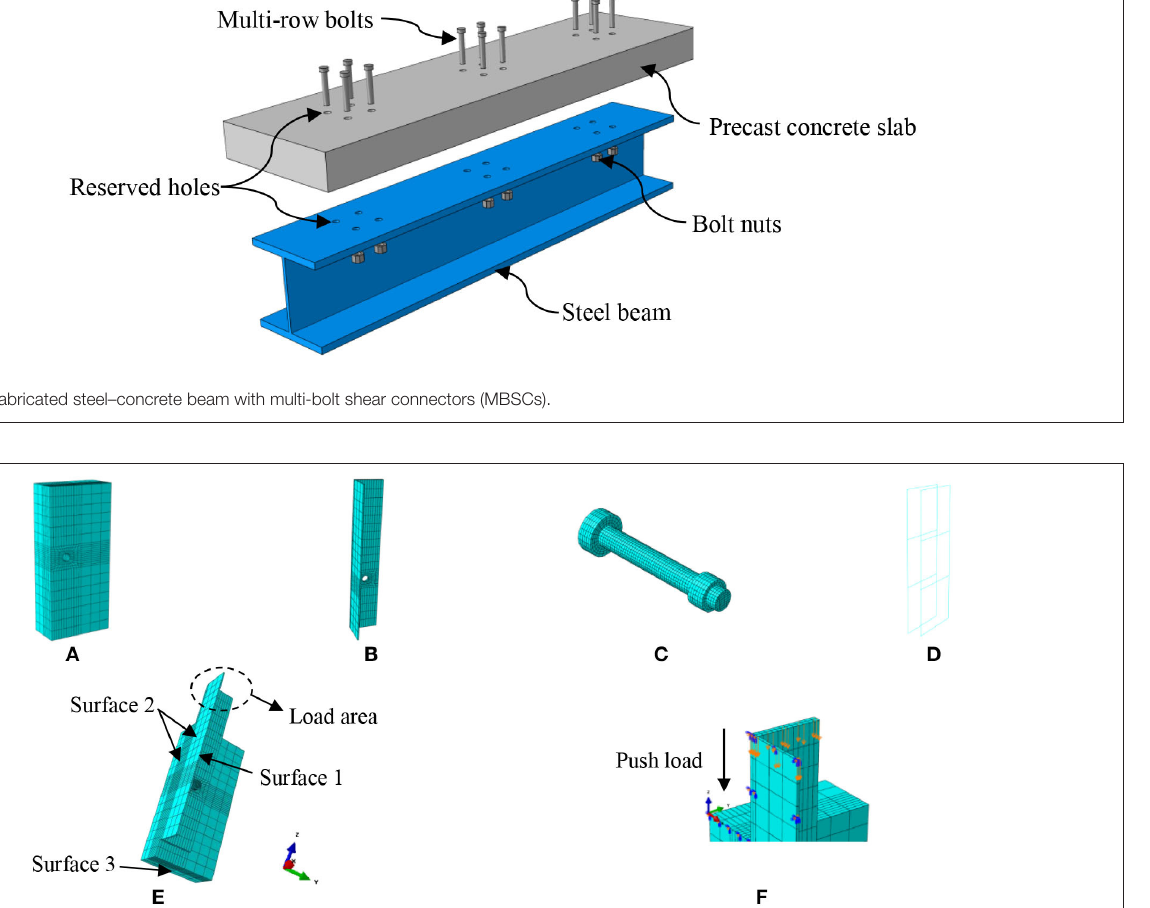
FIGURE 2 | Mesh generation and load diagram of finite element method (FEM): (A) concrete plate; (B) steel beam; (C) bolt shear connector; (D) steel cage; (E) FEM; and (F) load diagram of